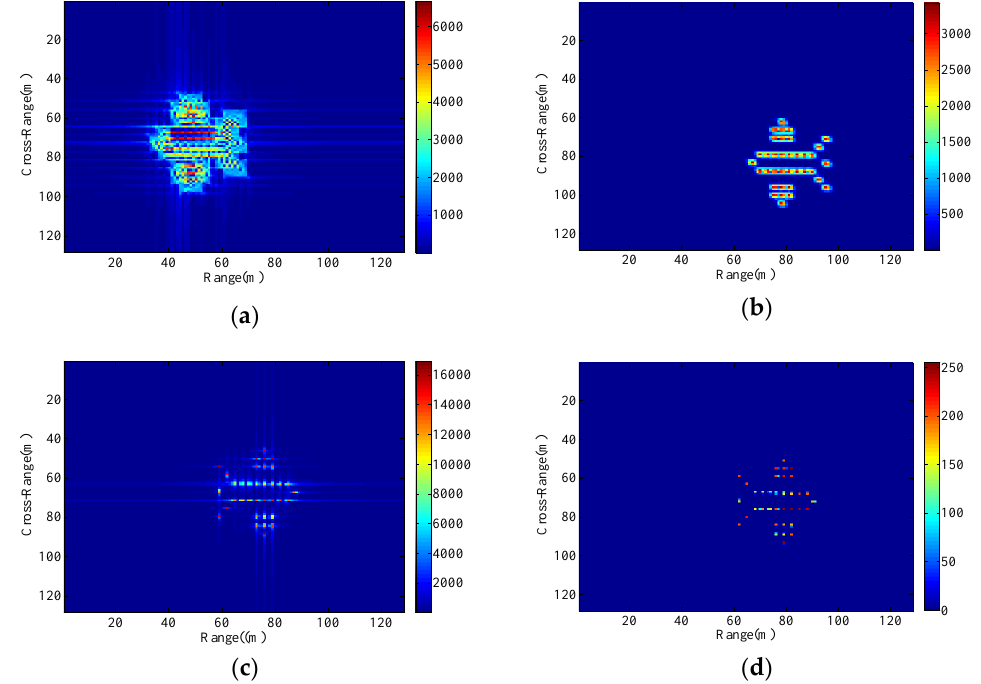
Figure 6. Imaging results with the radar platform displacement parameters P2. ( a ) RD algorithm; ( b ) cross-correlation method; ( c ) minimum entropy method; ( d ) the proposed method.